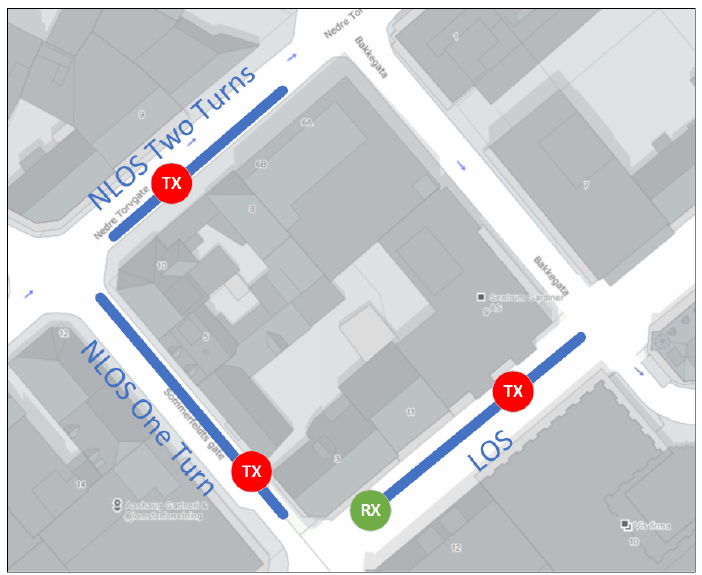
Figure 2. Satellite view of the area in which the measurements were conducted, the Rx was located at one location while the Tx was placed at different